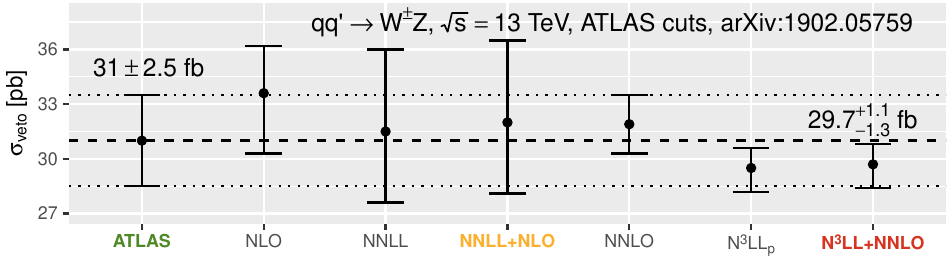
Figure 14 . Comparison of W ± Z jet-vetoed predictions with the ATLAS 13 TeV measurement [44]. Shown are results at fixed order, purely resummed and matched.